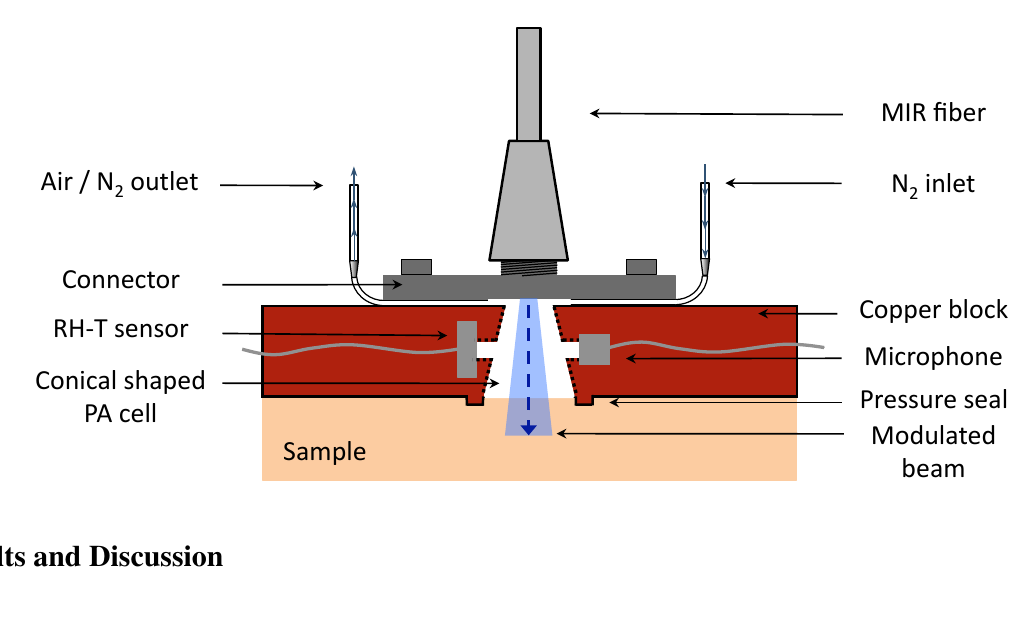
Figure 3. Schematic of the fiber-coupled PA cell. The PA chamber is conically shaped and closed directly by the sample itself. N ventilation is required, if a sample containing volatile 2 components like water is